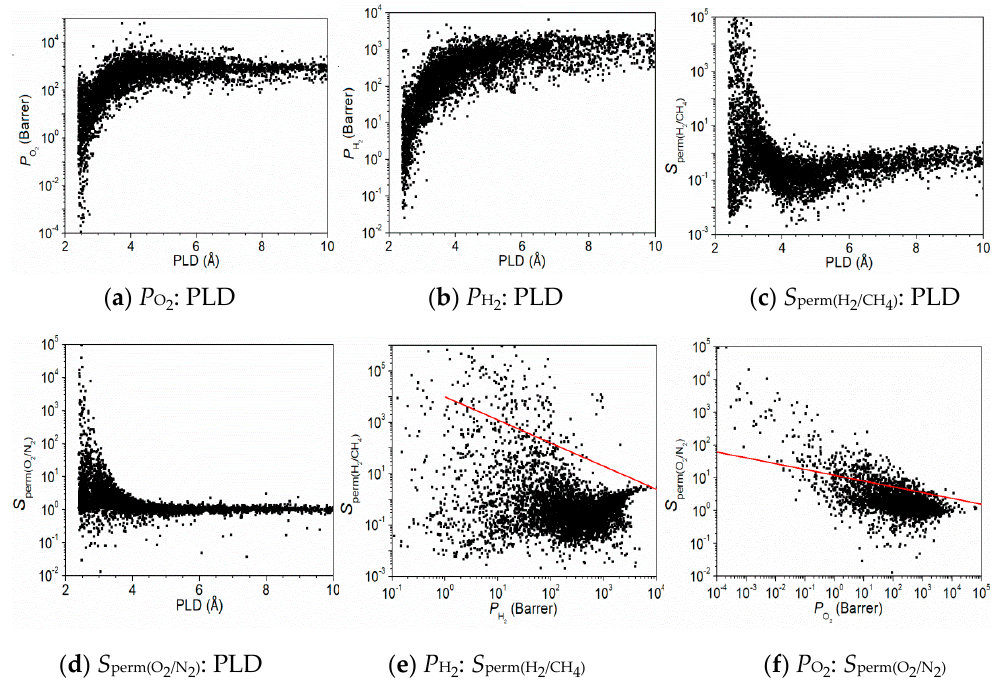
Figure 2. Relationships among ( a ) P O2 , ( b ) P H2 , and pore limiting diameter (PLD); relationships among (c) S perm(H2/CH4) , ( d ) S perm(O2/N2) , and PLD; relationship between ( e ) S perm(H2/CH4) and P H2 and ( f ) S perm(O2/N2) and P O2 ; the red line represents Robeson's penetration data based on a wide range of polymer film upper bounds [39].